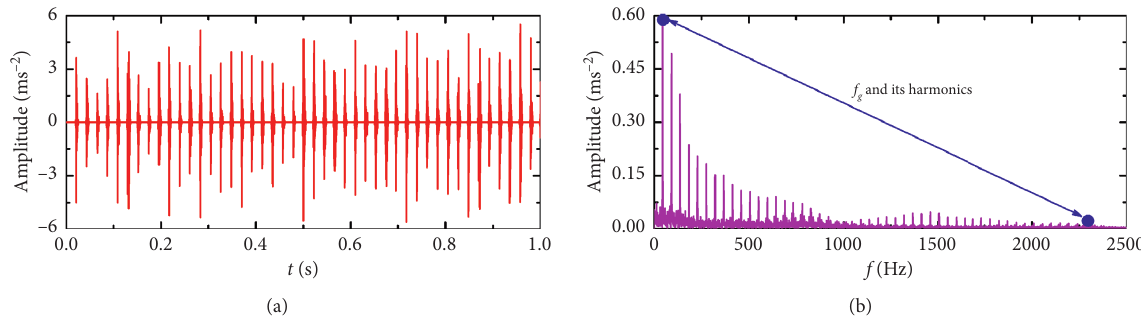
Figure 7: The simulated results using the ALIF-SBAKW method: (a) extracted signal and (b) Hilbert envelope spectrum of signal in